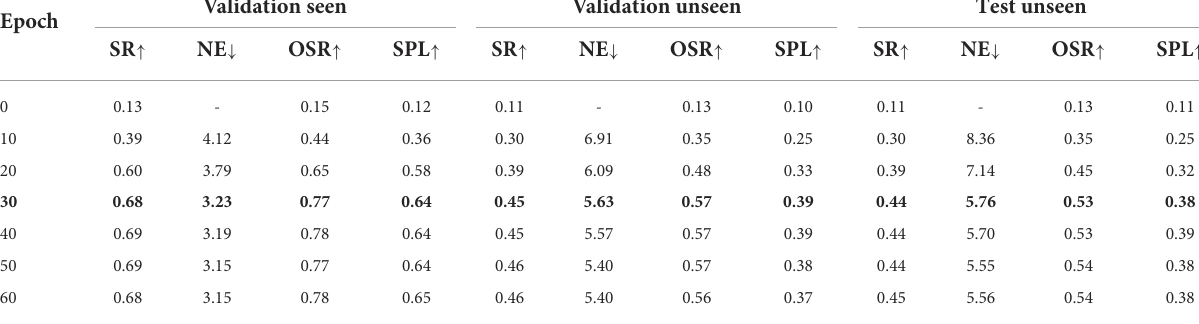
TABLE 1 The evaluation index results table.